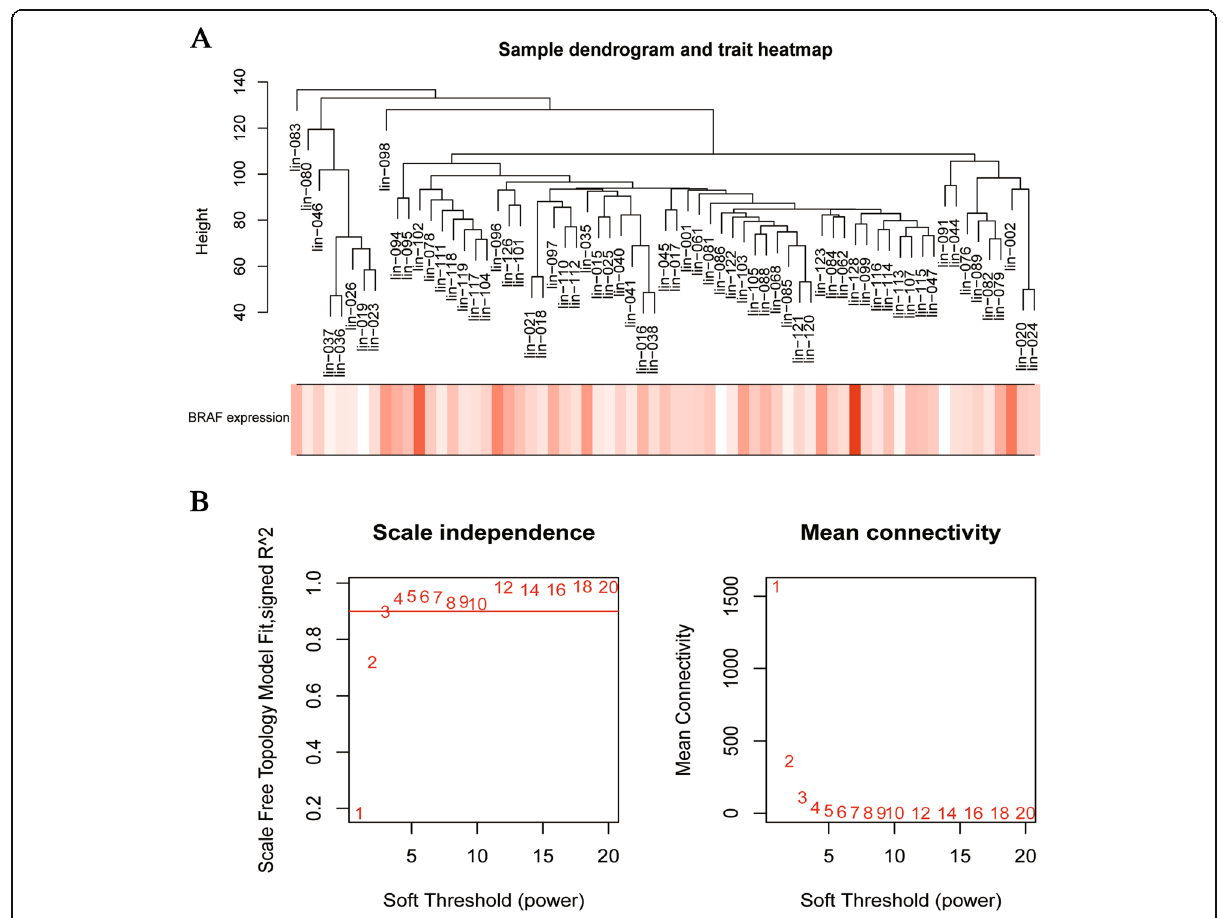
Fig. 2 The clustering of samples and selection of soft-thresholding power. a The clustering dendrogram of samples based on their Euclidean distance. b Analysis of the scale-free fit index for various soft-thresholding powers